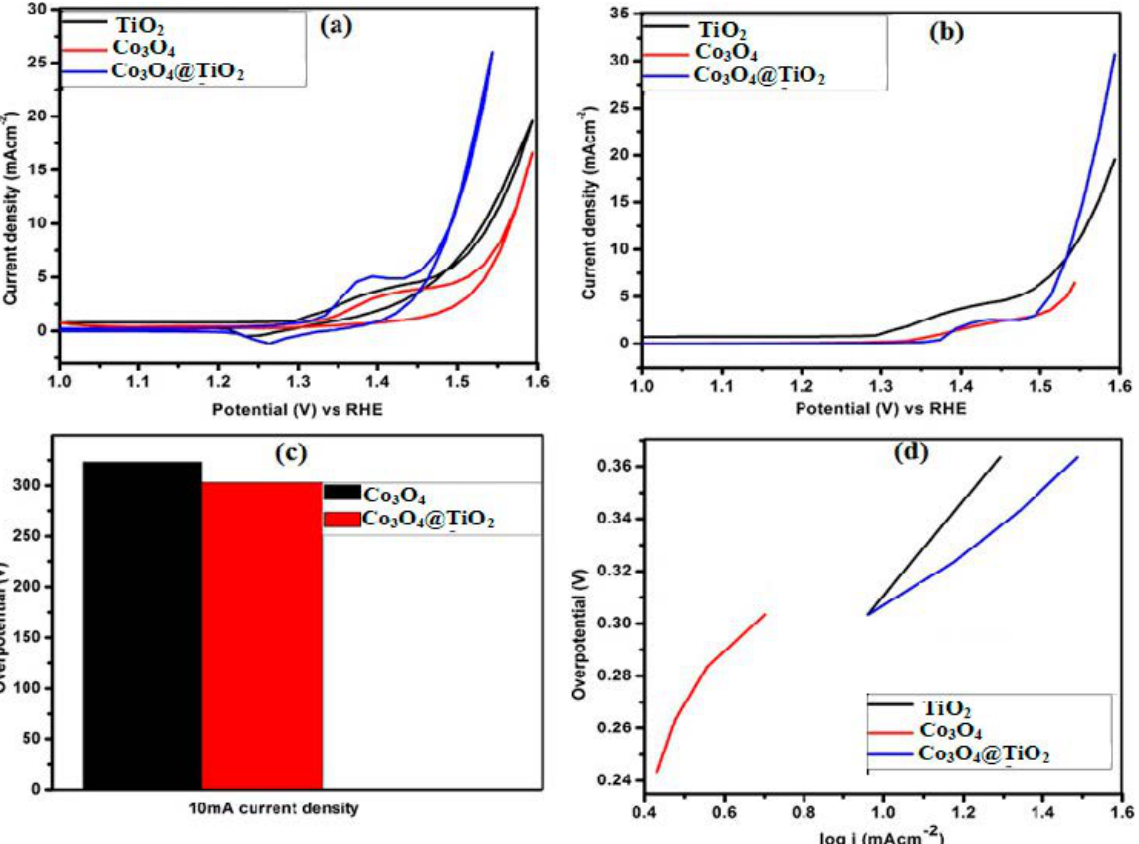
Figure 4. ( a ) CV, ( b ) LSV curves, ( c ) overpotential, and ( d ) Tafel plot for Co 3 O 4 , TiO 2 , and Co 3 O 4 @TiO 2 composite.